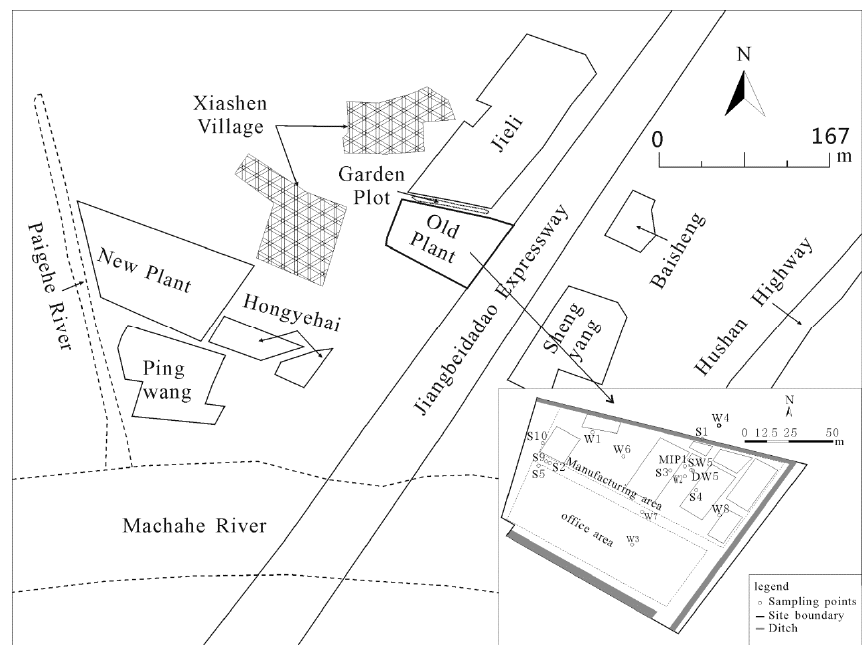
Figure 1. The schematic Location of Luhe site, Nanjing, China.